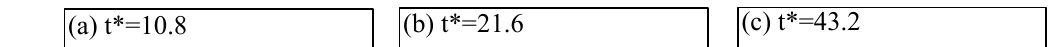
Fig. 4. Streamwise variation of vertical profiles of turbulence kinetic energy.